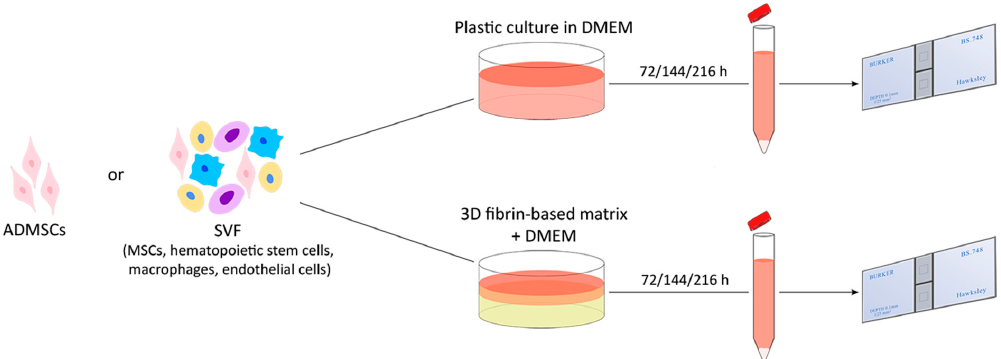
Figure A2 . Graphic representation of experiments performed with ADMSCs or SVF to determine cell growth by direct cell count, on plastic surface or inside a 3D environment. The same experimental scheme was applied, while different culture times and supplementations were used, as described in the Material and Methods section. Cells were maintained in 3.5 cm Petri dishes (6 well plates).